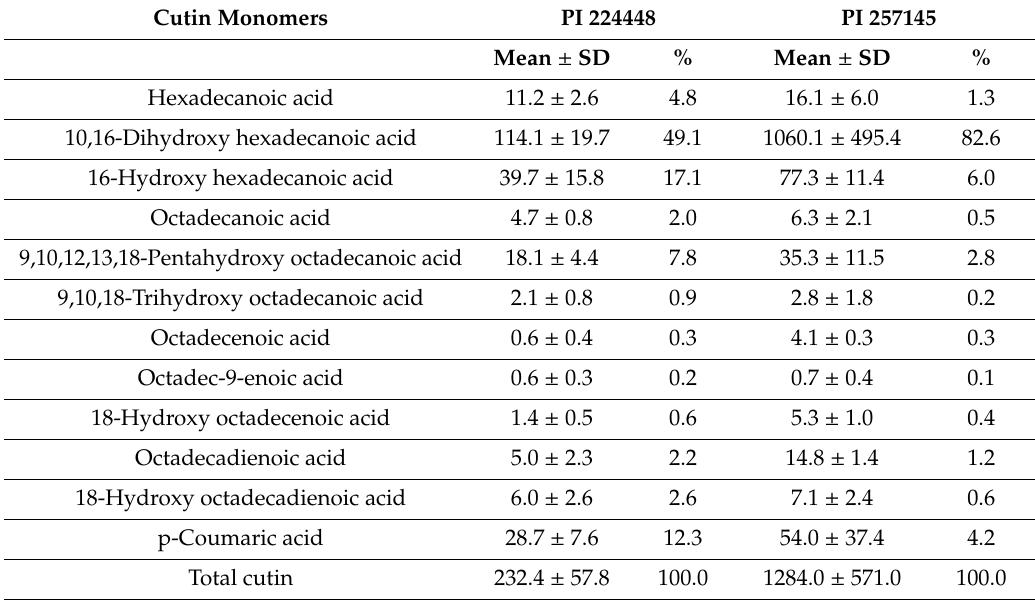
Table 1. Cutin monomers identified from habanero pepper fruits quantified by